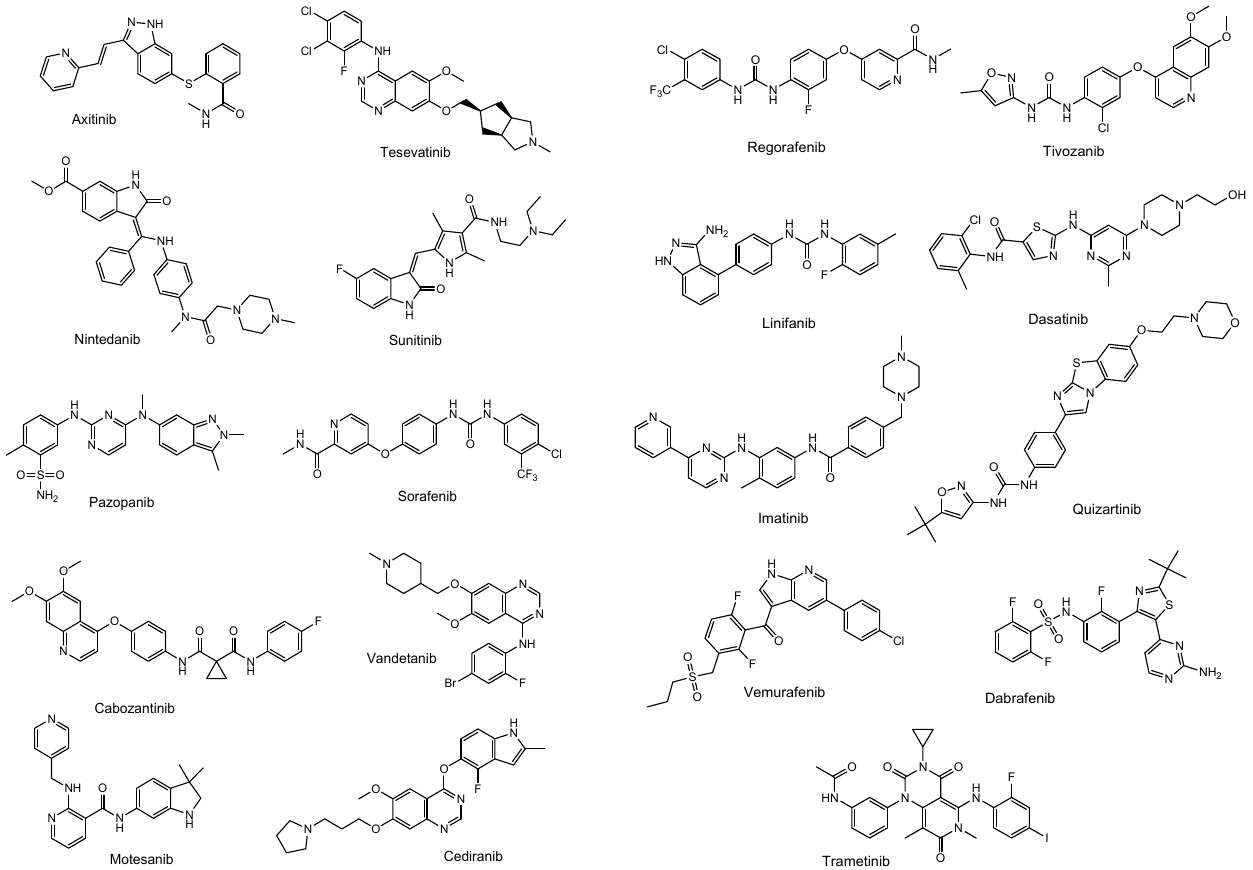
Figure 9. The structures of low-molecular drugs that are potential vascular endothelial growth factor (VEGF) inhibitors.